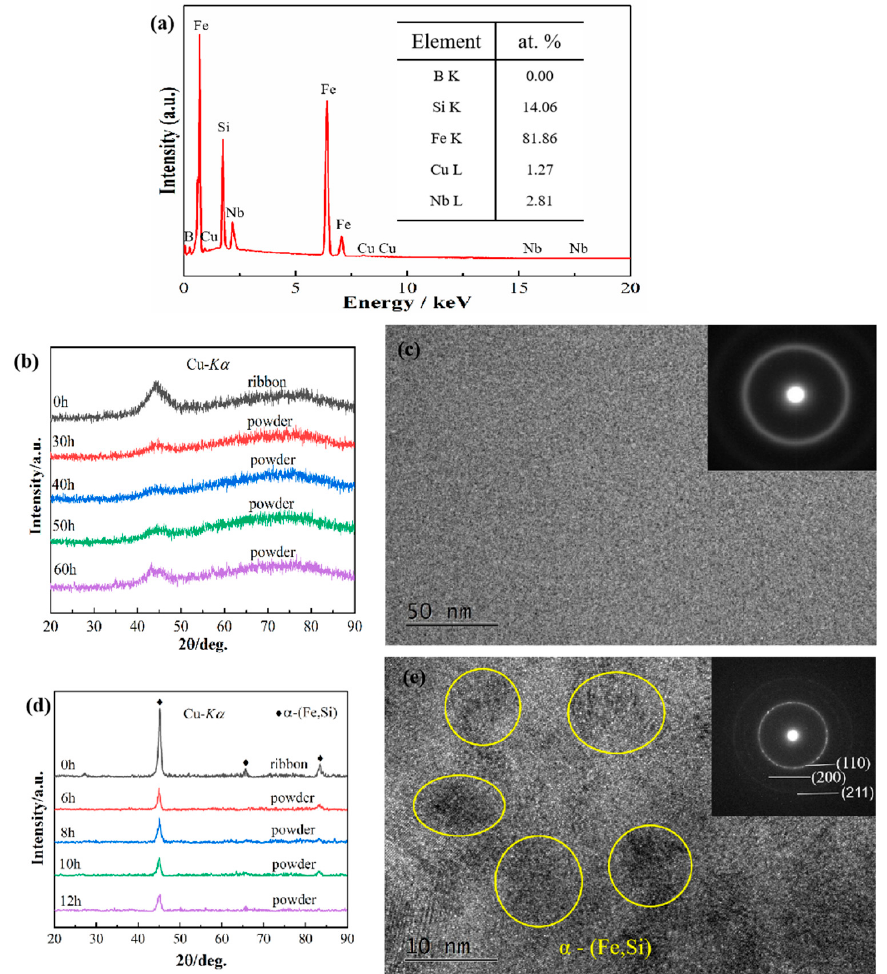
Figure 2. EDS map of Fe 73.2 Si 16.2 B 6.6 Nb 3 Cu 1 nanocrystalline ribbon, along with XRD patterns and TEM images of Fe 73.2 Si 16.2 B 6.6 Nb 3 Cu 1 amorphous alloy and nanocrystalline alloy: ( a ) EDS map of the nanocrystalline ribbon; ( b ) XRD patterns of amorphous alloy; ( c ) HRTEM and SAED images of